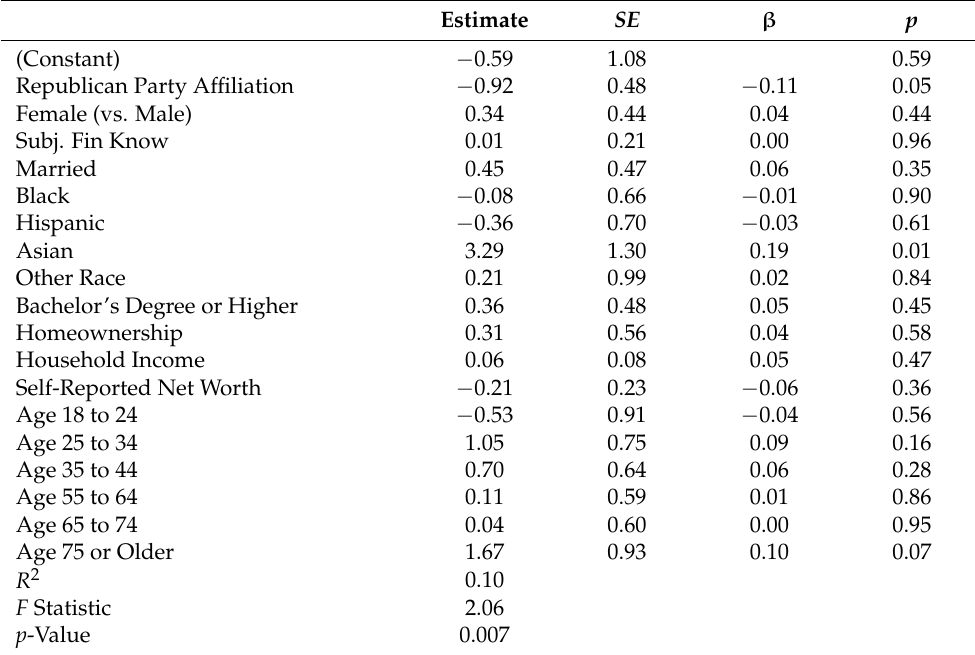
Table 7. Regression showing change in financial risk tolerance (FRT) from the Wave 1 to Wave 2 survey based on Republican Party affiliation.